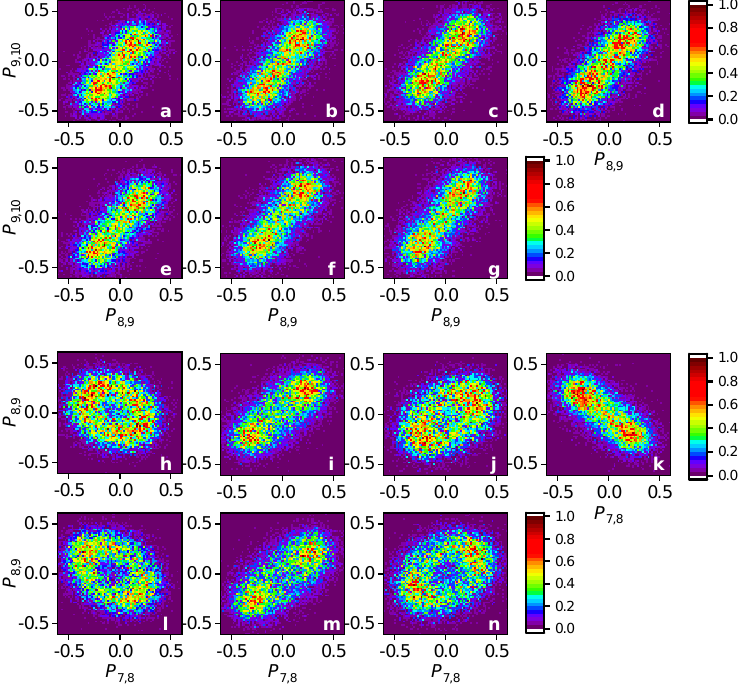
Figure 7. Experimental correlation plots for a phase scan using PS 3 in the four-harmonic case. ( a – g ) Evolution of the correlation plots of the oscillating components of the sidebands ( P 8,9 , P 9,10 ) for increasing values of the delay τ s 3 introduced by the phase shifter PS 3 . ( h – n ) Evolution of the correlation plots of the oscillating components of the sidebands ( P 7,8 , P 8,9 ) for increasing values of the delay τ s 3 introduced by the phase shifter PS 3 . The delay τ s 3 introduced by the phase shifter PS 3 affects only the phase of the harmonic H 7 , resulting in fixed correlation plots of ( P 8,9 , P 9,10 ) ( a – g ). The color scale indicates the density of single-shot experimental points normalized to unity for each